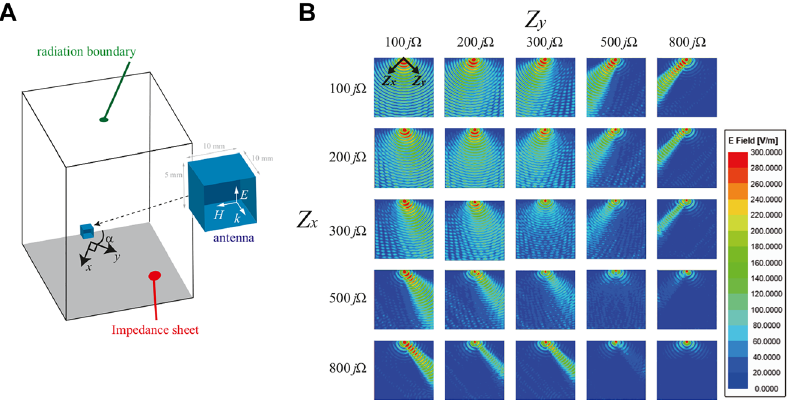
Figure 2: Simulation of surface wave propagation on an anisotropic impedance surface based on an impedance sheet model. (A) Simulation setup where x and y axes are fixed using 𝛼 = 45 ◦ . (B) Electric field profiles for surface wave propagation on an anisotropic impedance surface with various impedances in the x and y directions. The surface impedances in the x and y directions vary as indicated by and Z determining how the surface wave the variation in Z x y